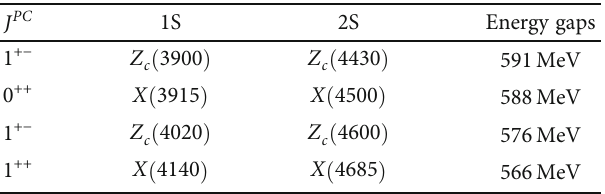
Table 1: The energy gaps between the ground states and fi rst radial excited states of the hidden-charm tetraquark states with the possible